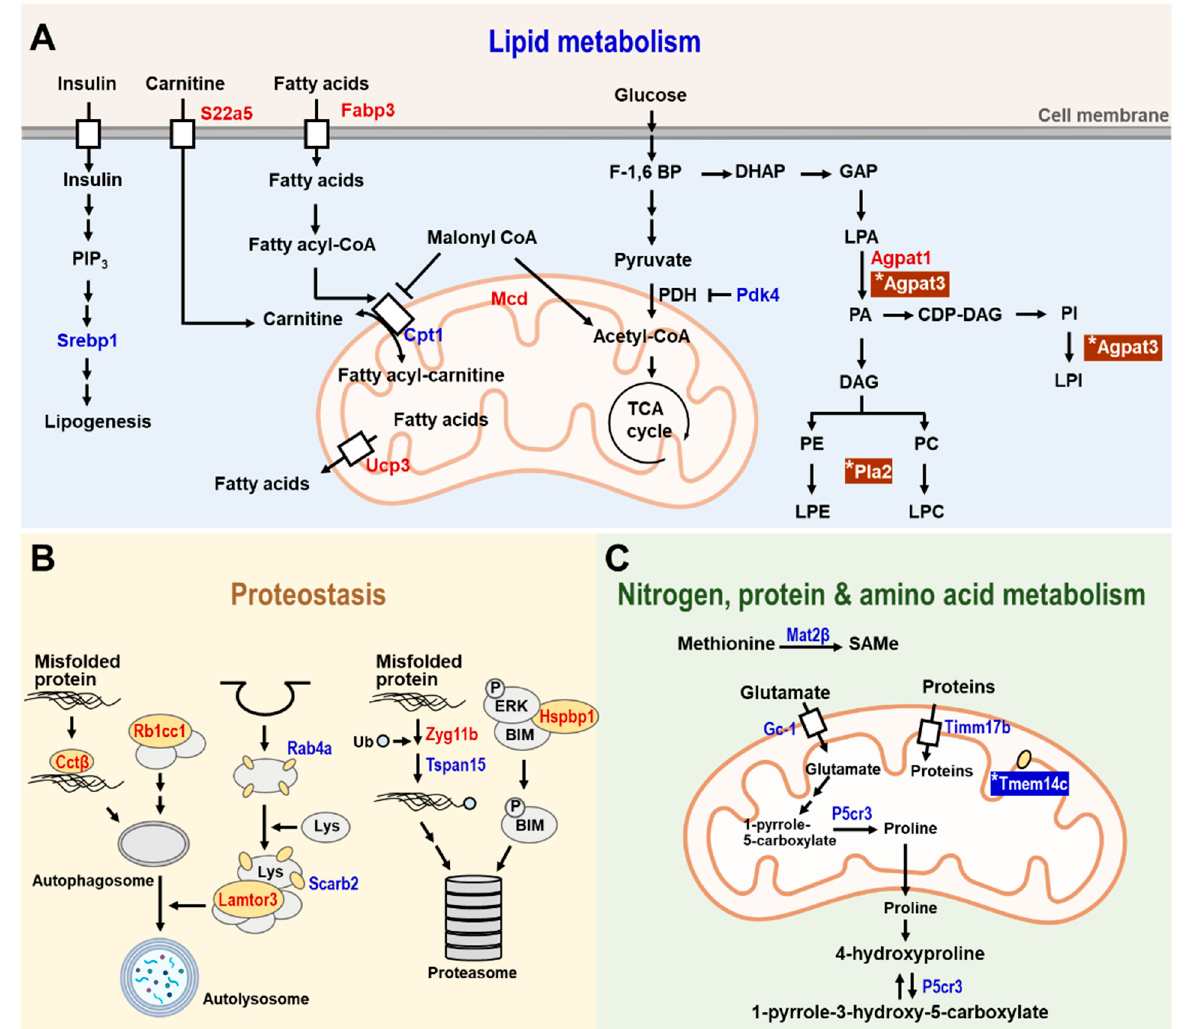
Figure 4. The CISD2-dependent and CISD2-independent metabolic pathways identified in the skeletal muscle of 3-month-old WT and CISD2 mcKO mice who undergo hesperetin treatment for 4 months. A schematic illustration of metabolism in the hesperetin-treated and vehicle-treated CISD2 mcKO mice that carry a CISD2 knockout background specifically affecting the skeletal and cardiac muscles. In aged skeletal muscle (gastrocnemius), hesperetin brings about improvements in various dysregulated pathways, namely ( A ) lipid metabolism, ( B ) proteostasis and ( C ) nitrogen, protein, and amino acid metabolism. Red indicates upregulation and blue indicates downregulation of the identified proteins. The presence of (*) emphasizes that these proteins were affected by hesperetin in a CISD2-independent manner. The figure was created with